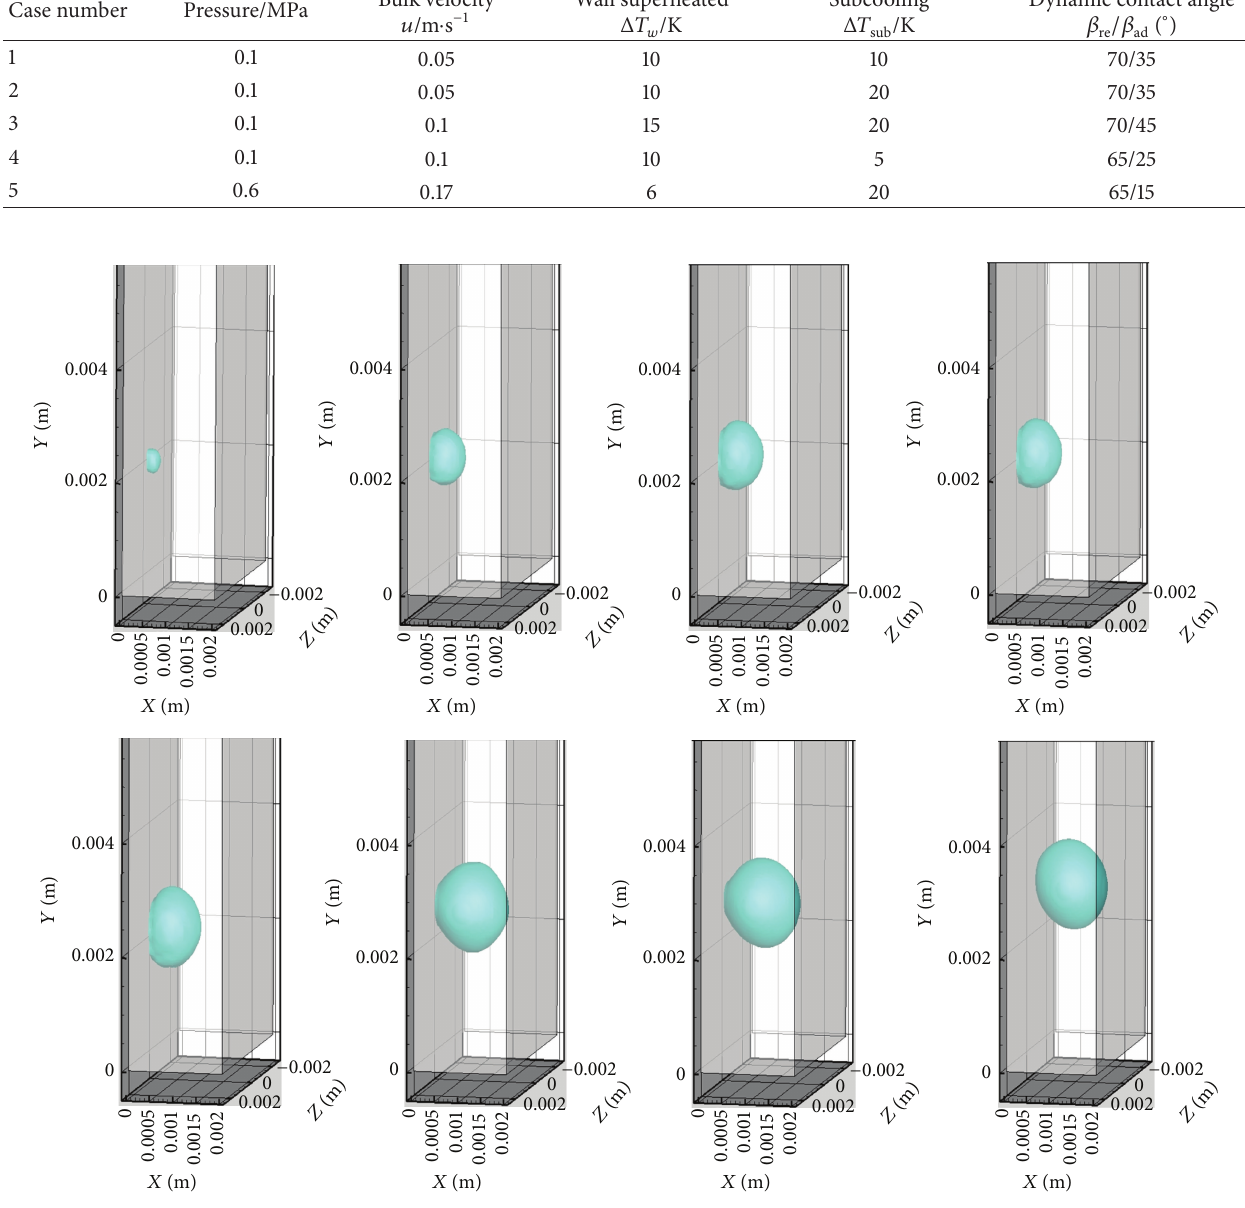
Figure 4: The evolution of bubble shape in bubble growth and detachment process on case 1